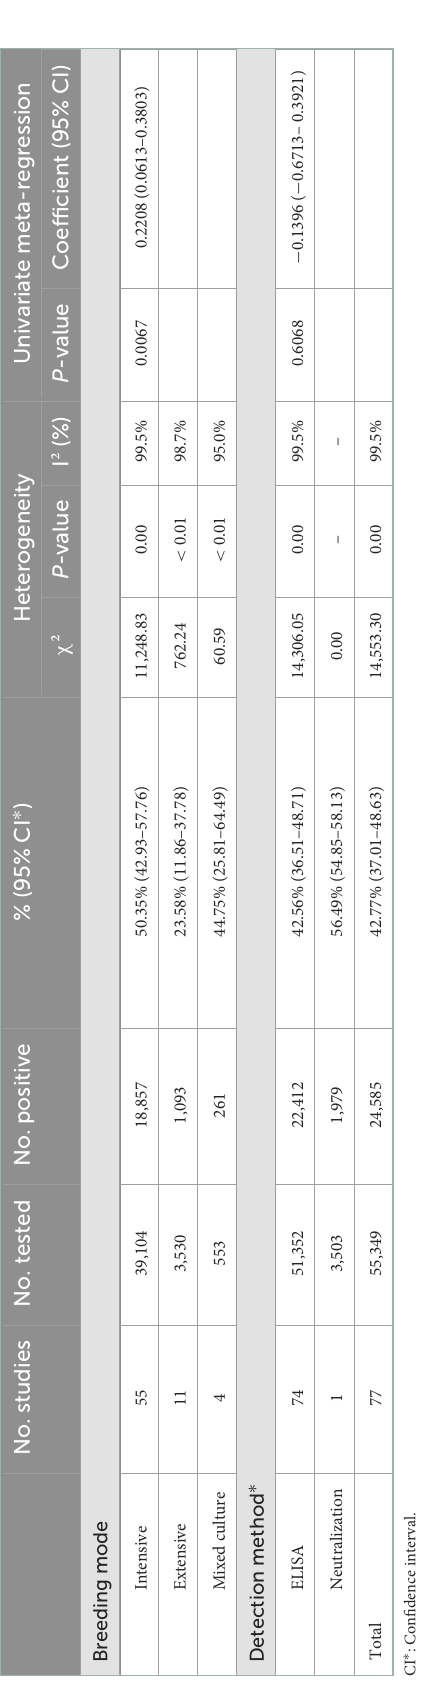
Table 2) in North America. Spain (59.40%, 95% CI: 50.91– 67.62, Supplementary Table 1) has the highest antigen-positive rate among all countries and India has the lowest positive rate.